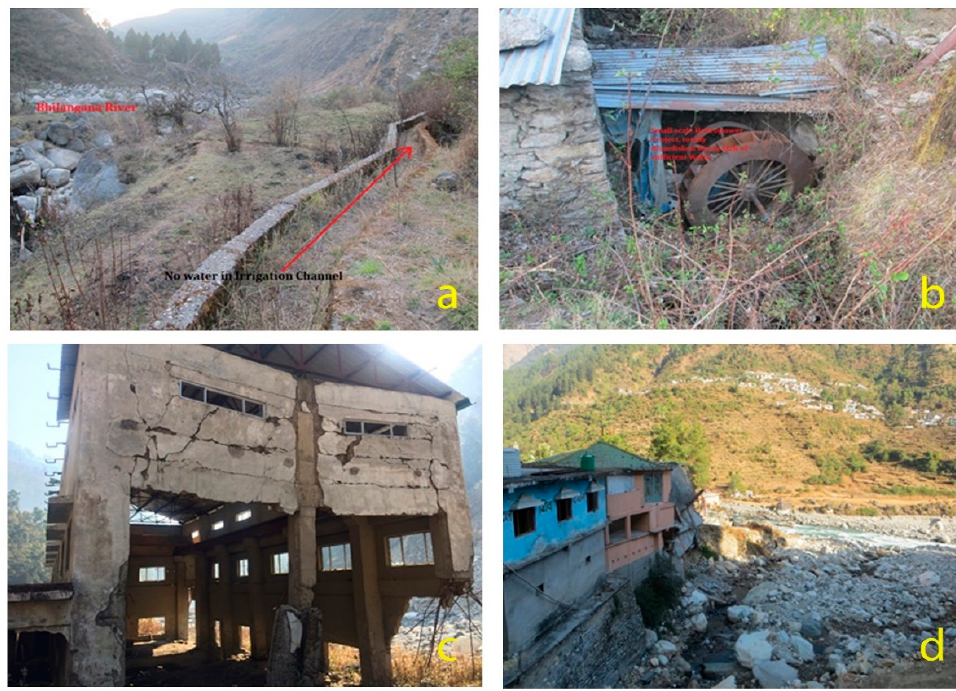
Figure 10. ( a – d ) Regional consequences of alternations in annual, seasonal and monthly rainfall pattern from 1983 to 2018. ( a , b ) show some effects of decreased rainfall; ( c , d ) the state of property after a major rainfall event. Localities of photos a-d are shown in Figure 1. Photos: A.B.